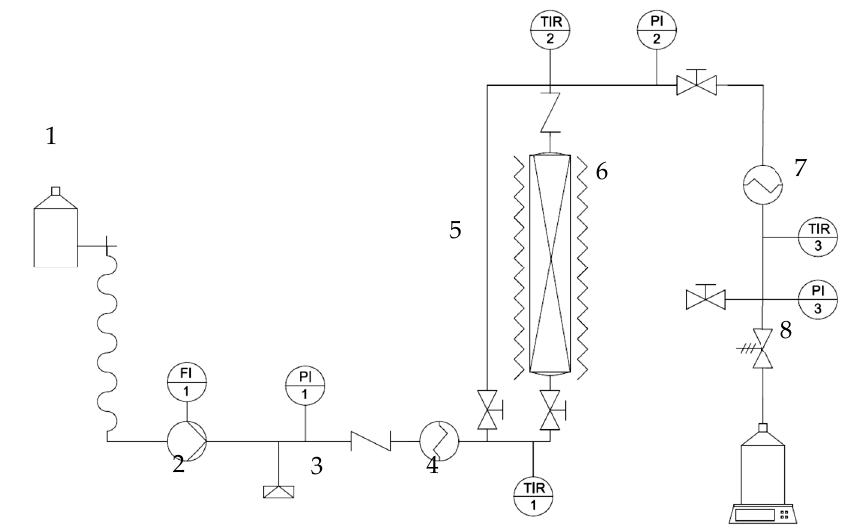
Figure 1. Subcritical water laboratory scale extraction plant used in this work. (1) Solvent bottle; (2) pump; (3) bursting disk; (4) heater; (5) by-pass pipe; (6) extractor; (7) chiller; and (8) backpressure